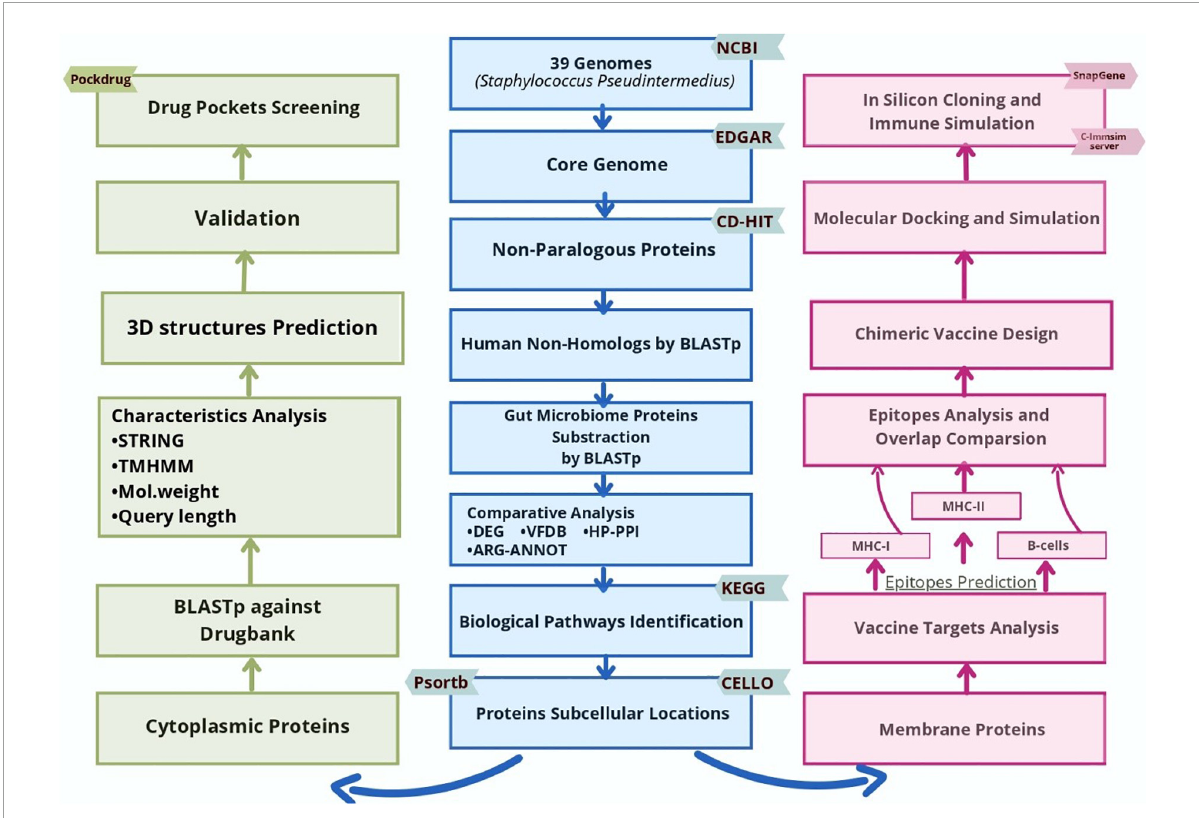
FIGURE1 Flowchart of subtractive proteomics and reverse vaccinology approach followed for the potential drug and vaccine identifications against S. pseudintermedius